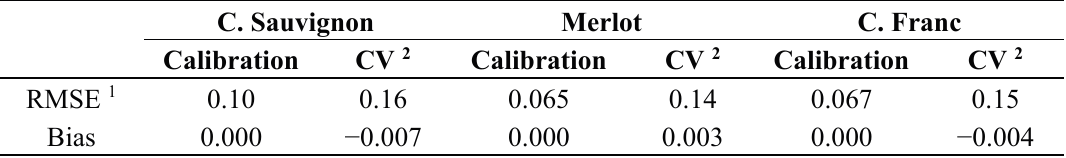
Table 1. Model performances in calibration and cross-validation.